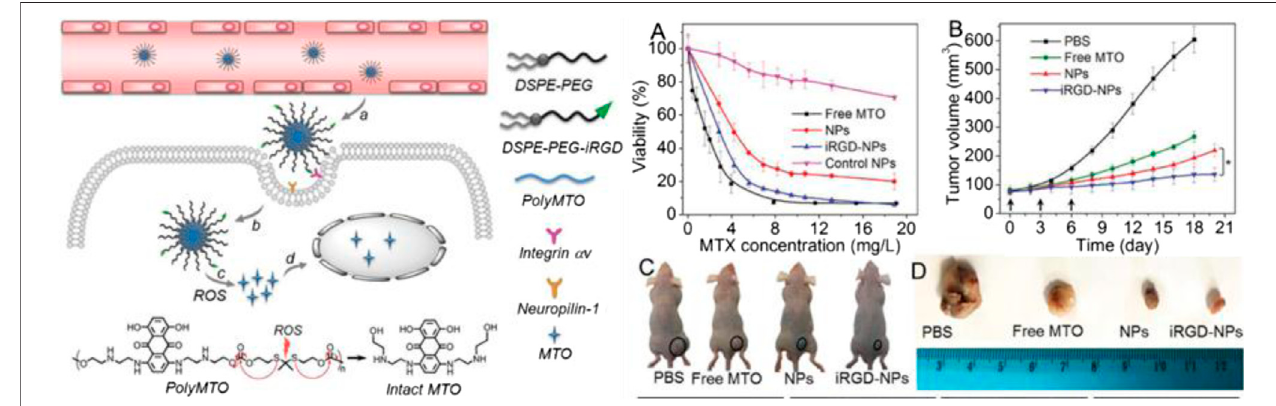
FIGURE 6 | Schematic diagram of the mechanism for release of intact anticancer drug molecules mitoxantrone (MTO) and the chemical structure of polyMTO. (A) Cytotoxic effects induced by different polyMTO-based nanoparticles. (B) Curves of tumor volumes following treatment with different prodrug polyMTO-based nanoparticles. (C) Photograph of tumor-bearing mice; tumors are indicated by circles. (D) Photograph of tumor volume after treatment with PBS and various prodrug polyMTO-based nanoparticles (Xu X. et al., 2017). Copyright 2017, John Wiley and Sons.